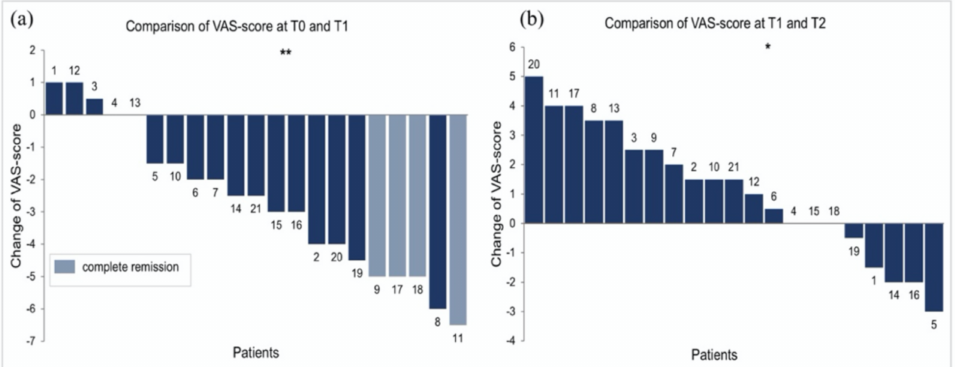
Figure 3. Waterfall plots depicting individual patients’ changes of VAS scores. Numbers 1–21 indicate individual patients: ( a ) VAS score changes from T0 (baseline) to T1 (after four weeks of CSA). An increase in VAS scores was found in 3 (patients 1, 12, 3), no change in 2 (patients 4, 13) and a reduction in VAS scores in 16 patients ( p = 0.0003). Four patients were free of pain after four weeks of topical CSA (light blue). ( b ) VAS score changes from T1 to T2 (after four weeks without treatment). An increase in VAS scores was found in 13 patients, no change in 3 (patients 4, 15, 18) and a further reduction in VAS scores in 5 (patients 19, 1, 14, 16, 5) ( p = 0.032). * p ≤ 0.05, ** p ≤